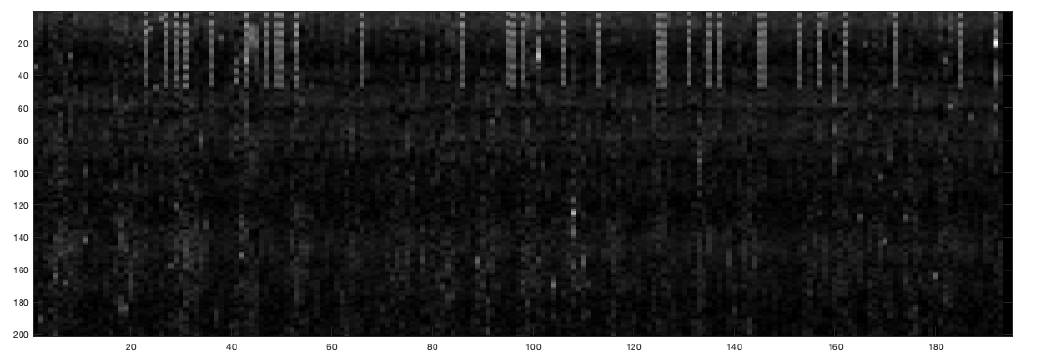
Figure 7. ST segments of each heartbeat showing the presence of VLPs on some of the recorded beats.